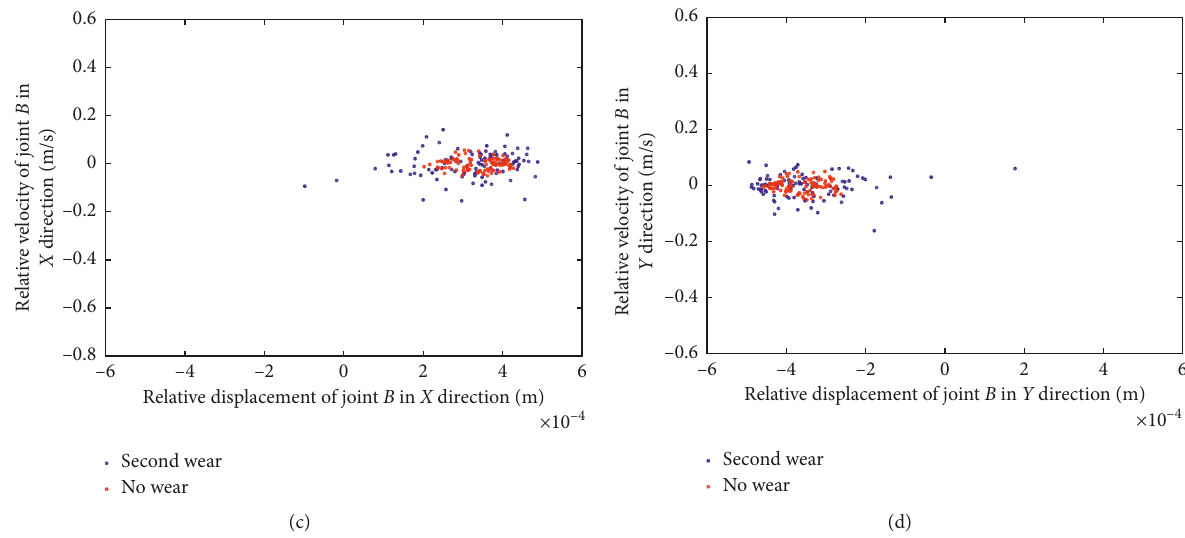
Figure 28: Poincar´e mapof(a)joint A inthe X direction,(b)joint A inthe Y direction,(c)joint B inthe X direction,and(d)joint B inthe Y direction.